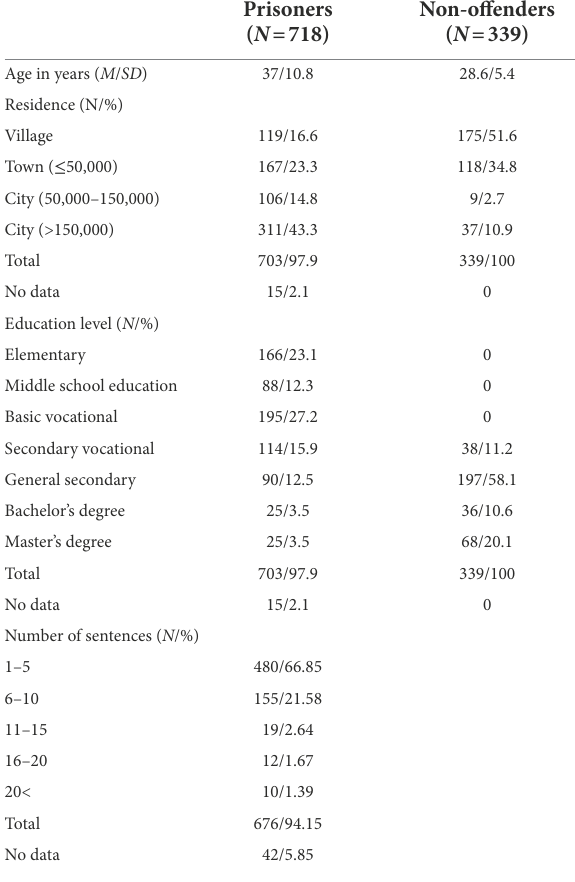
TABLE 1 Descriptive statistics for demographic